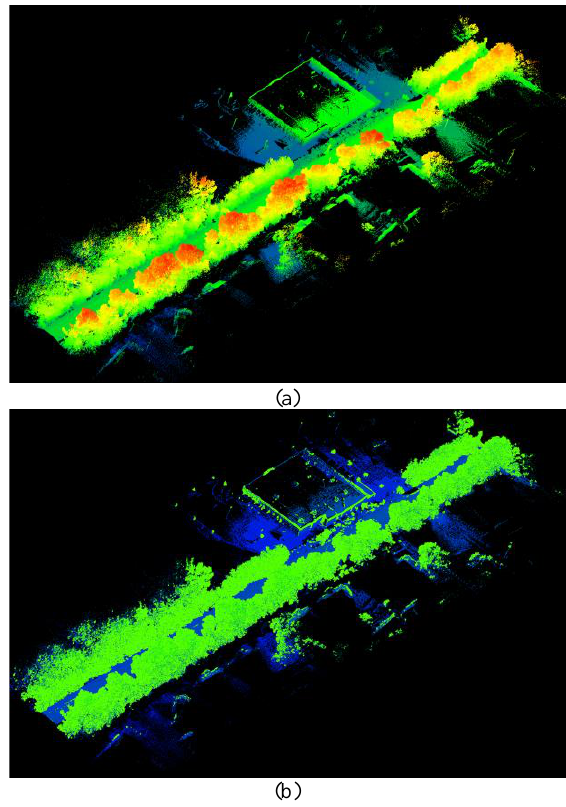
Figure 7. Lidarusa railway dataset; (a) collected LiDAR point clouds; (b) Output of the proposed